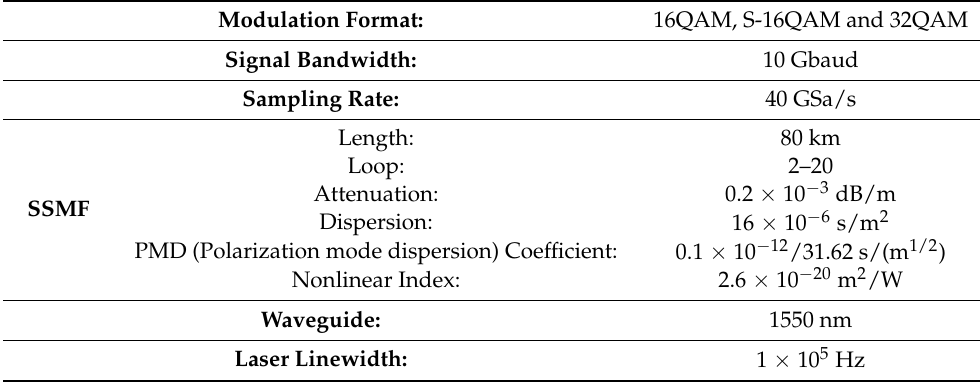
Table 1. The key parameters of the